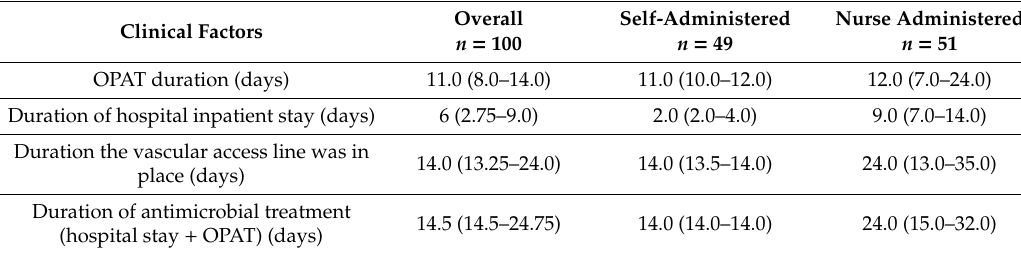
Table 1. Median duration (interquartile range) of